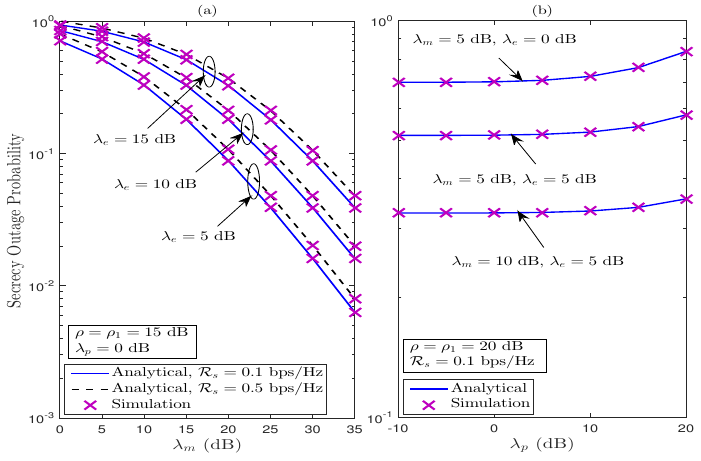
Figure 7. SOP performance for the considered system under Strategy II, ( a ) SOP versus λ m , and ( b ) SOP versus λ p